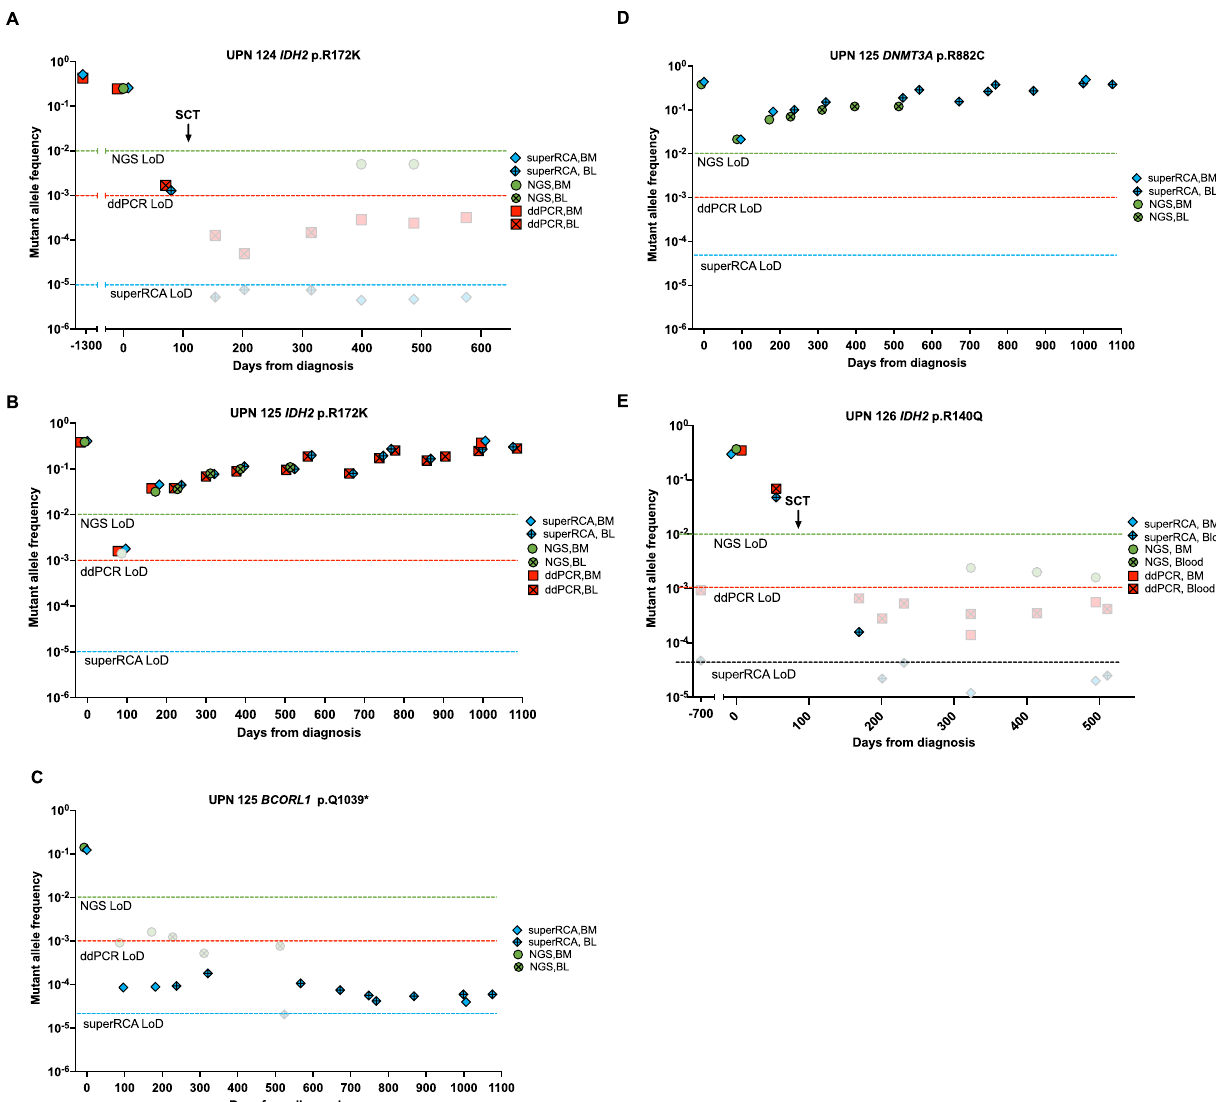
Fig. 6 Follow-up of three AML patients using ddPCR, NGS and superRCA assay. A Patient UPN124 was diagnosed with AML on day 0 with high levels of the IDH2 p.R172K mutation, and drug therapy was initiated. SCT was performed on day 126, at which point considerable levels of the mutation remained, as recorded via superRCA and ddPCR, but all subsequent samples post-SCT have been negative, indicating a complete remission. A bone marrow sample taken three and a half years prior to AML diagnosis demonstrated high levels of the IDH2 p.R172K mutation when retrospectively analyzed by superRCA and ddPCR assays. B Patient UPN125 was followed-up with respect to the IDH2 p.R172K mutation. For UPN125, NGS of a BM sample taken at AML diagnosis (day 0) revealed high levels of IDH2 p.R172K,mutation, and subsequent superRCA and ddPCR analyses of the same sample recorded similar levels of the mutation. After 3 months of therapy, NGS no longer demonstrated the IDH2 p.R172K mutation at signi fi cant levels in the BM sample obtained during clinical remission, whereas subsequent analysis by superRCA and ddPCR assays revealed signi fi cant levels of this mutation. All the following samples have been positive by all three detection techniques, consistent with the patient ’ s clinical relapse. C Patient UPN 125 was followed by analyses of the BCORL1 p.Q1039* mutation. The NGS and retrospective superRCA analysis revealed high levels of the BCORL1 p.Q1039* mutation in the diagnostic samples collected on Day 0, but in samples collected during clinical remission from Day 97, the mutation levels had been suppressed to background by NGS and to 10 − 4 by superRCA. D Patient UPN 125 was followed with respect to the DNMT3A p.R882C mutation. Analysis by NGS and superRCA showed that the DNMT3A p.R882C mutation was initially present at a high frequency (MAF 0.38 and 0.44, respectively). and then persisted after treatment despite morphological remission as previously described for preleukemic mutations affecting DNMT3A mutations. The patient subsequently relapsed to an MDS phase without blast excess. E UPN126 was diagnosed with primary myelo fi brosis two years prior to AML diagnosis. The bone marrow sample at AML diagnosis (day 0) revealed high levels of the IDH2 p.R140Q mutation as recorded via NGS, superRCA and ddPCR. Retrospective analysis of the initial bone marrow sample at the myelo fi brosis stage was negative for the IDH2 p.R140Q mutation by superRCA and ddPCR. SCT was performed on day 139, at which point considerable levels of the mutation remained. The IDH2 p.R140Q mutation was detected at low levels by superRCA approximately three months post SCT, whereas ddPCR failed to identify the detectable levels of the mutation at that timepoint. All subsequent samples have been negative in blood and bone marrow by superRCA and ddPCR, indicating a complete